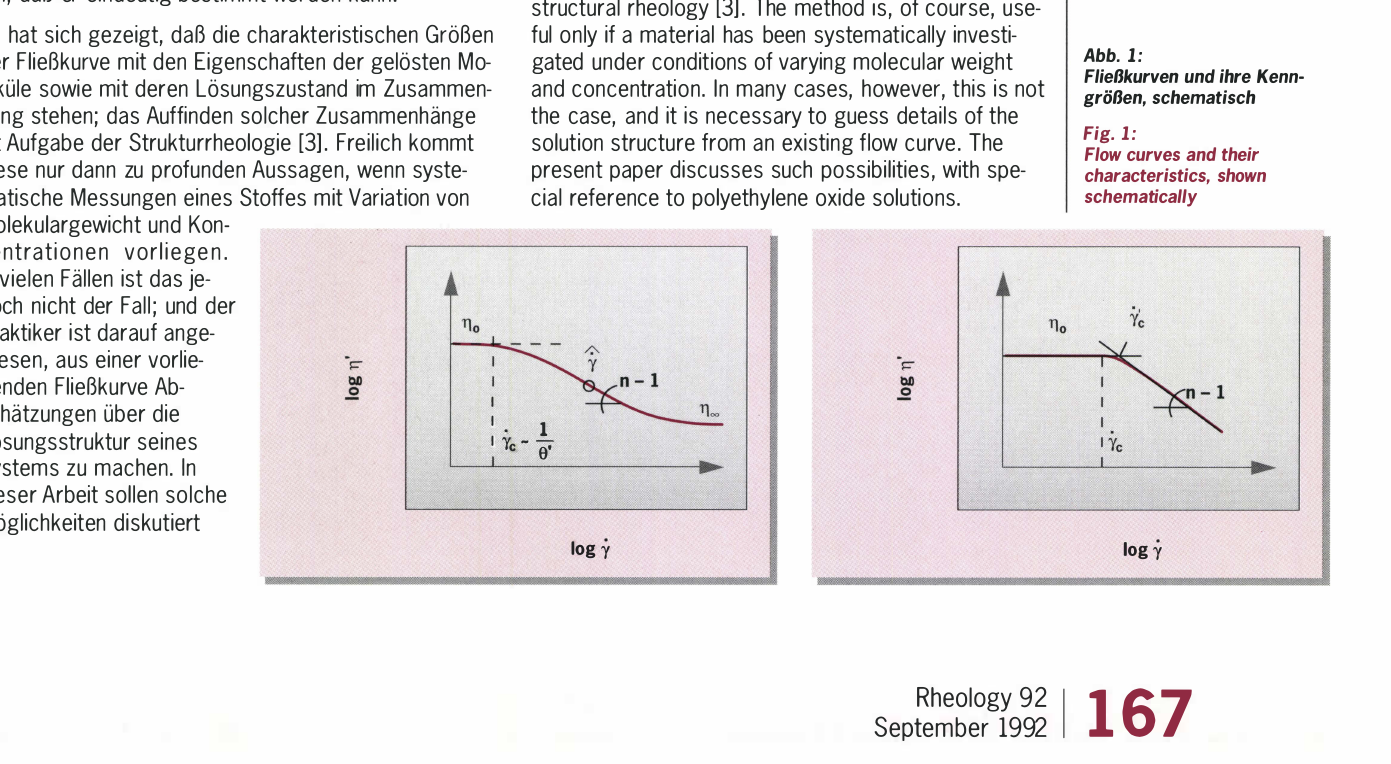
Fig. 1: Flow curves and their characteristics, shown